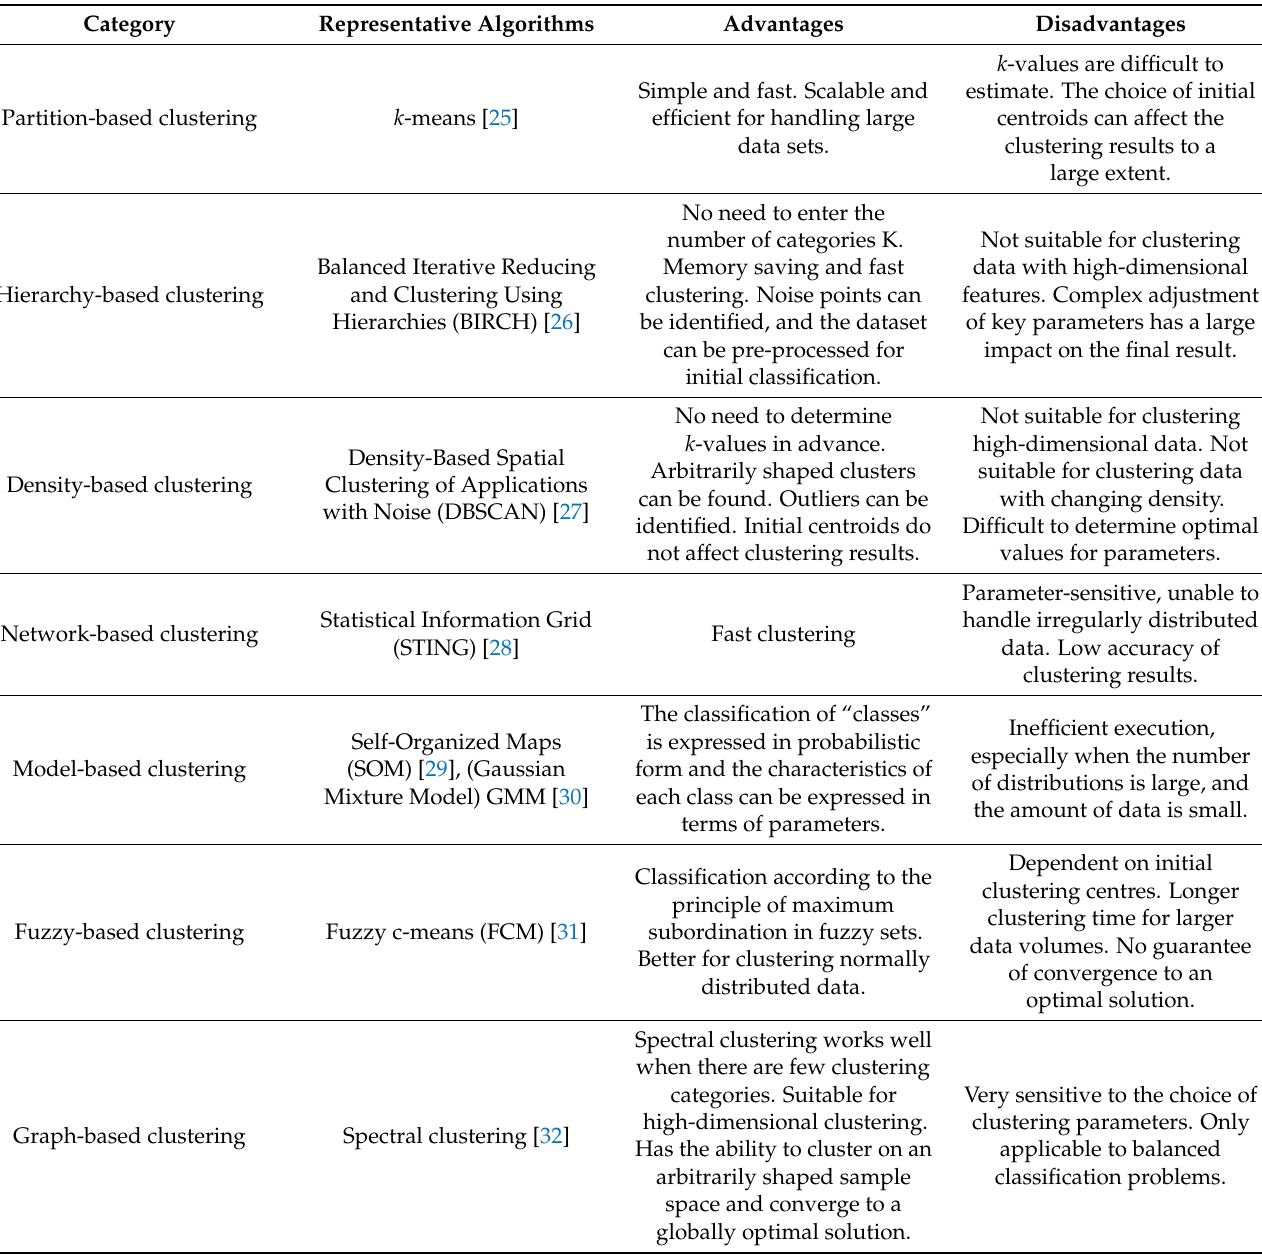
Table 1. Commonly used clustering algorithms and their advantages and